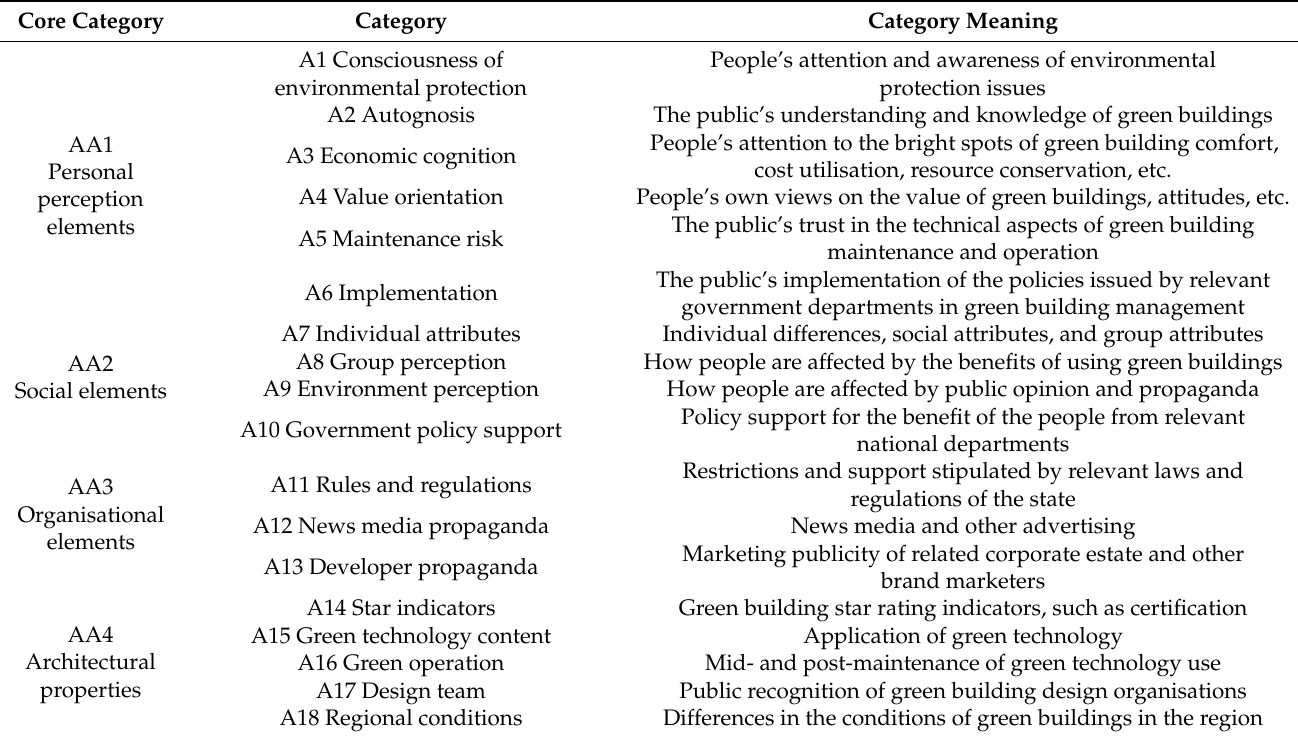
Table 4. Axial coding of interview data on the cognitive influencing factors of green building based on interviews with the general